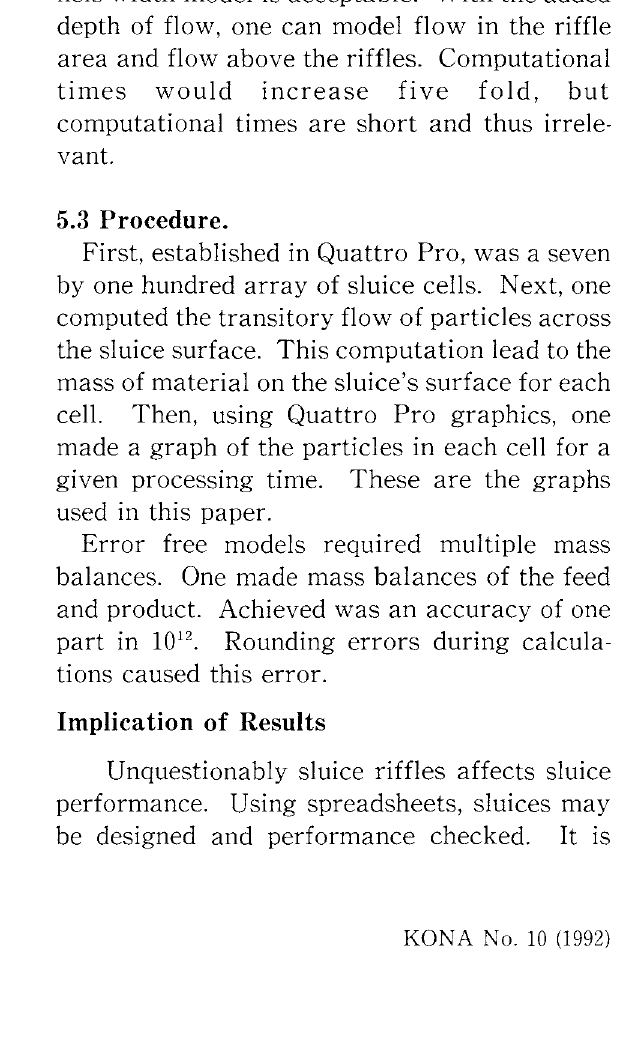
Fig. 7a Flat profile and high bias after 300 seconds.